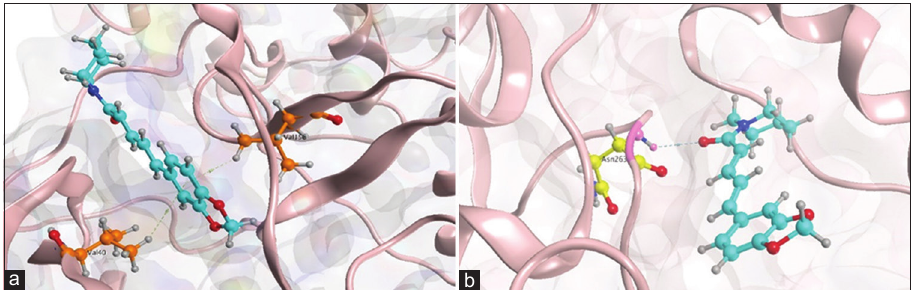
a Fig ure-1: Model of competitive inhibition of piperine (PIP) on the components of the Mitogen-activated protein kinases/ NF-B axis. (a) Visualization of the 3D PIP ligand interaction with the JNK-1 active site. (b) Visualization of the 3D PIP ligand interaction with the active site of inhibitor of nuclear factor-kappa B kinase beta subunit.